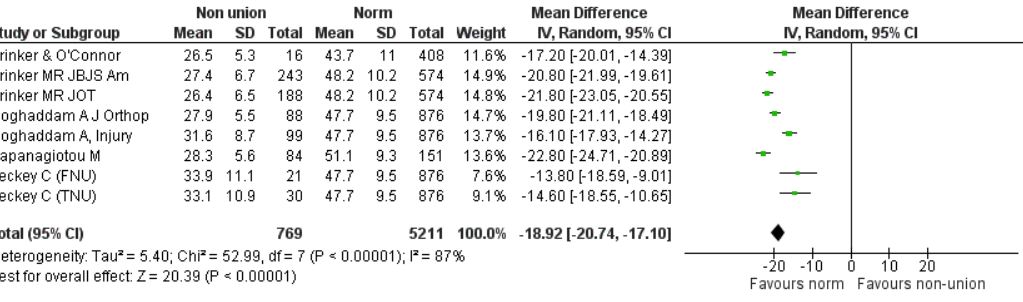
Figure 3. SF-12 PCS pooled analysis of non-union versus normal population.